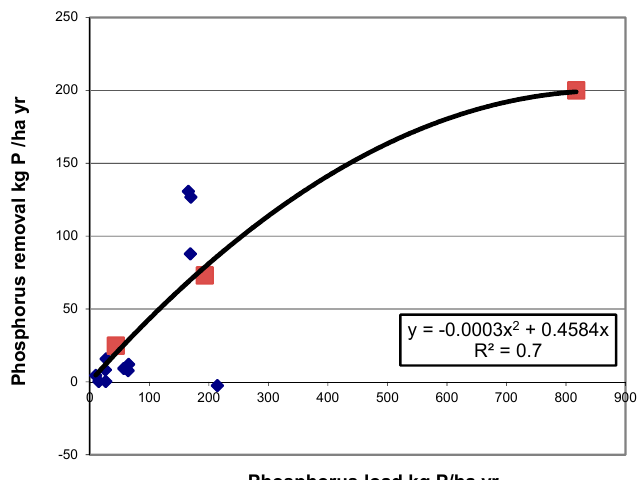
Figure 2. Relationship between phosphorus load and removal (kg per hectare wetland area and year), based on water sampling in inlet and outlet of 15 created wetlands in agricultural areas in southern Sweden. Data from automatic flow proportional water sampling in 3 wetlands and strategic grab sampling in 12 wetlands are indicated with different symbols. The regression model R = − 0.0003L 2 + 0.4584L, where R = annual phosphorus removal per wetland area (kg ha − 1 yr − 1 ) and L = annual phosphorus load per wetland area (kg ha − 1 yr − 1 ) was used for modelling of phosphorus removal in 60 selected wetlands.